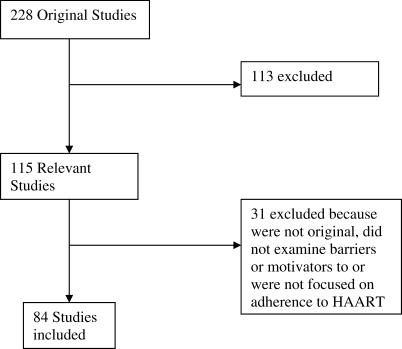
Flow Chart of Studies Included in Review